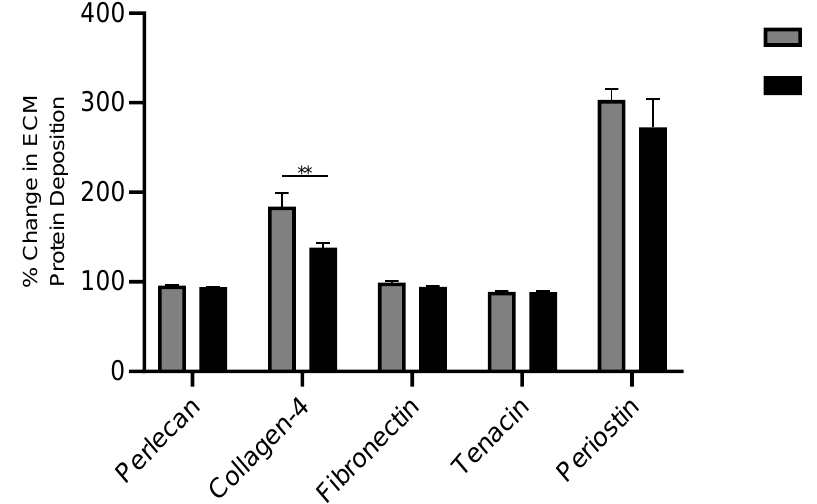
3FN, indicating the better efficacy of 2FN compared to 3FN.